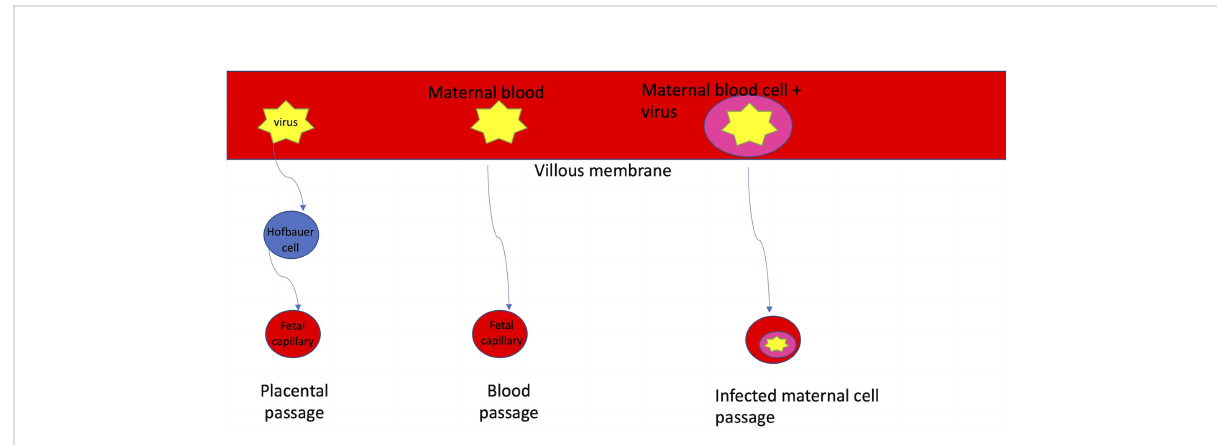
FIGURE 1 Modes of maternal to placenta SARS-CoV-2 virus